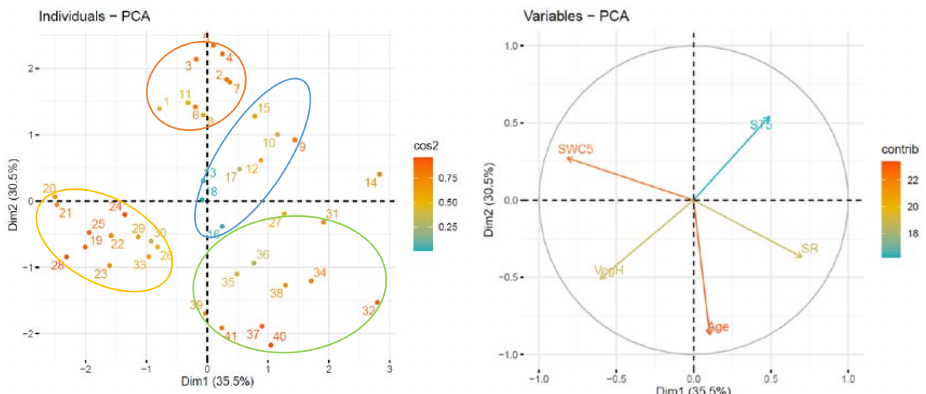
Figure 3. Correlation principal component analysis (PCA) of the studied environmental parameters (variables PCA; right) and various age groups of the burnt areas (individuals PCA; left). Individuals PCA: ( 1 ), 0.25-year-old burnt areas; ( 2 ), 1-year-old burnt areas; ( 3 ), 2-year-old burnt areas; ( 4 ), 3-year-old burnt areas; ( 5 ), 4-year-old burnt areas; ( 6 ), 5-year-old burnt areas; ( 7 ), 6-year-old burnt areas; ( 8 ), 10-year-old burnt areas; ( 9 ), 11-year-old burnt areas; ( 10 ), 13-year-old burnt areas; ( 11 ), 14-year-old burnt areas; ( 12 ), 15-year-old burnt areas; ( 13 ), 16-year-old burnt areas; ( 14 ), 17-year-old burnt areas; ( 15 ), 21-year-old burnt areas; ( 16 ), 22-year-old burnt areas; ( 17 ), 29-year-old burnt areas; ( 18 ), 54-year-old burnt areas; ( 19 ), 88-year-old burnt areas; ( 20 ), 89-year-old burnt areas; ( 21 ), 90-year-old burnt areas; ( 22 ), 97-year-old burnt areas; ( 23 ), 99-year-old burnt areas; ( 24 ), 100-year-old burnt areas; ( 25 ), 101-year-old burnt areas; ( 26 ), 103-year-old burnt areas; ( 27 ), 105-year-old burnt areas; ( 28 ), 110-year-old burnt areas; ( 29 ), 140-year-old burnt areas; ( 30 ), 141-year-old burnt areas; ( 31 ), 150-year-old burnt areas; ( 32 ), 151-year-old burnt areas; ( 33 ), 153-year-old burnt areas; ( 34 ), 200-year-old burnt areas; ( 35 ), 260-year-old burnt areas; ( 36 ), 263-year-old burnt areas; ( 37 ), 270-year-old burnt areas; ( 38 ), 272-year-old burnt areas; ( 39 ), 274-year-old burnt areas; ( 40 ), 275-year-old burnt areas; ( 41 ), 276-year-old burnt areas. Variables PCA: SR , mean soil respiration; Age , burnt area age; ST5 , mean summer soil temperature; SWC5 , mean summer water content; VegH , vegetation cover height. cos2 , the squared cosine which represents the quality of representation for variables on the factor map. contrib , the contributions (in %) of the variables to the principal